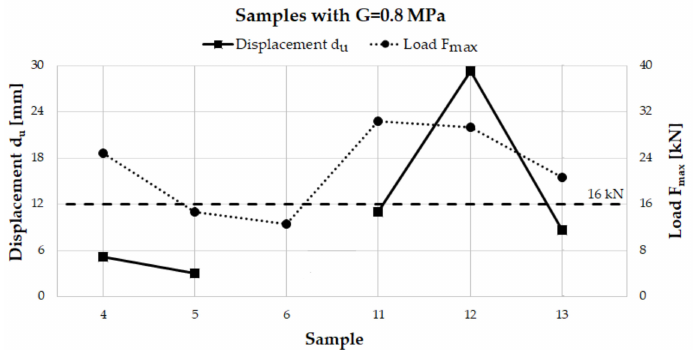
Figure 8. Test results in terms of displacements and loads for samples with G = 0.8 MPa.